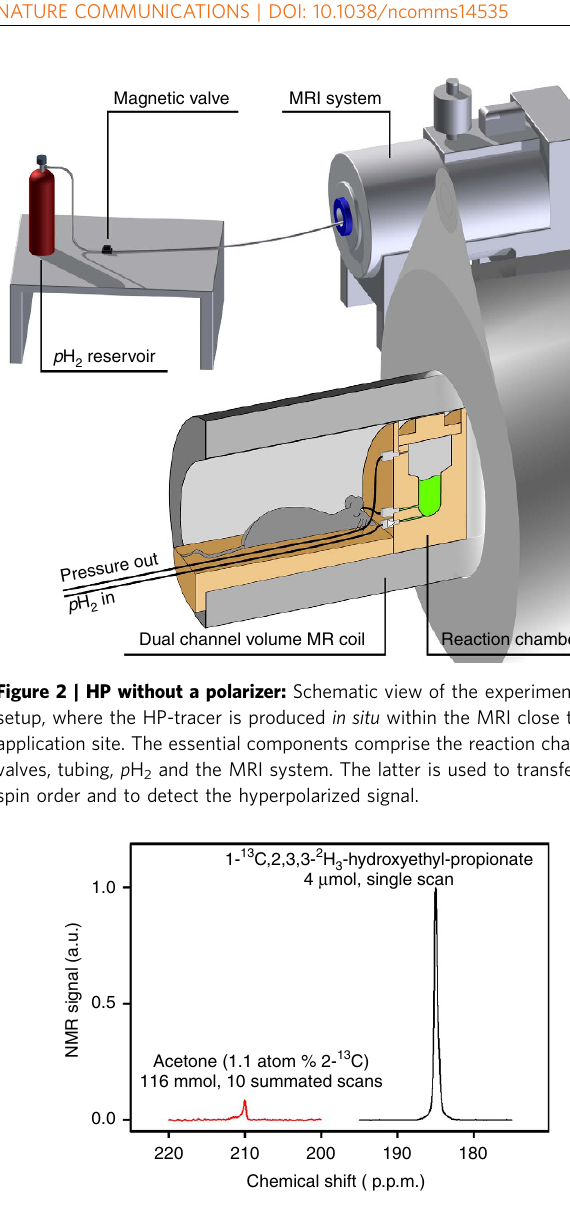
Figure 3 | 13 C-HP generated inside an MRI system. Non-localized 13 C-spectra of thermally polarized acetone at natural abundance (red) and 13 C-HEP in aqueous solution (black) hyperpolarized by SAMBADENA within an MRI system. The polarization yield was quantified to B 24%, which corresponds to a B 40,000-fold enhancement of the thermal 13 C-polarization which amounts to B 6p.p.m. at 7T.